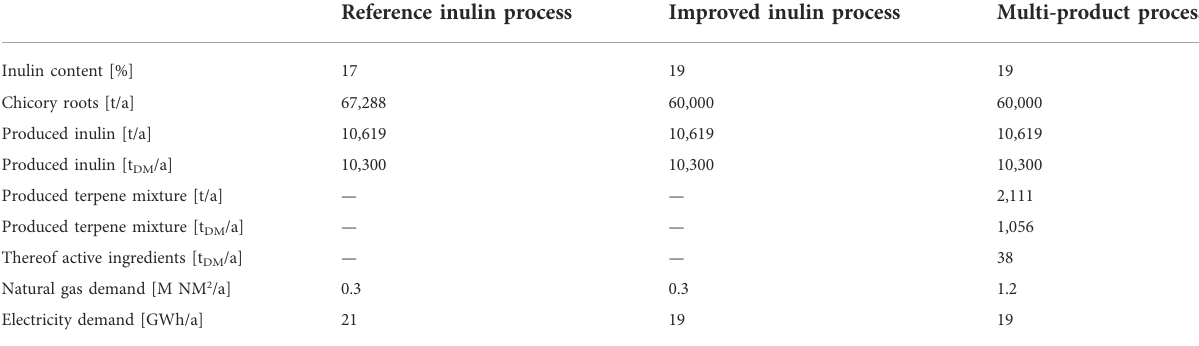
TABLE 2 Data on yield and energy demand of